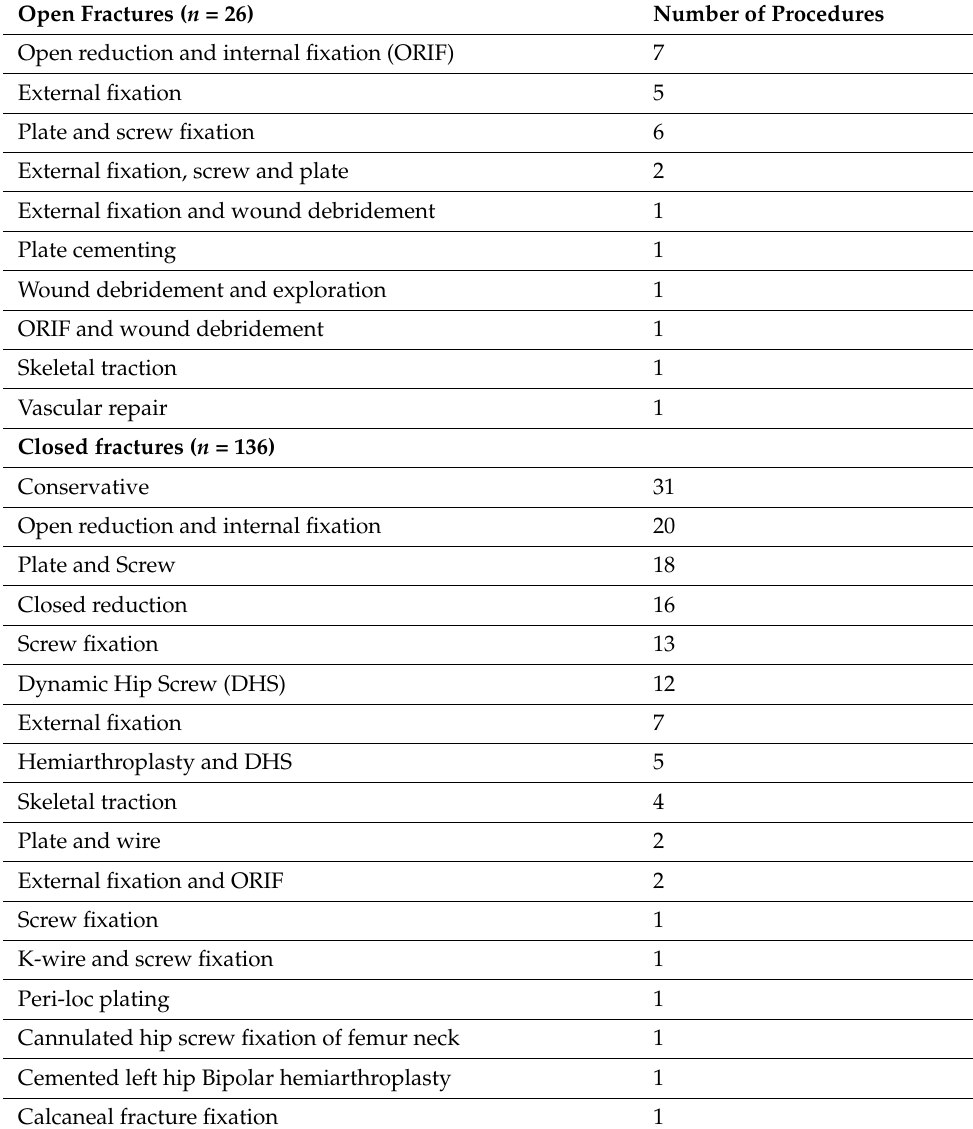
Table 5. Management approach for femur fracture (non-IM nailing cases) n =